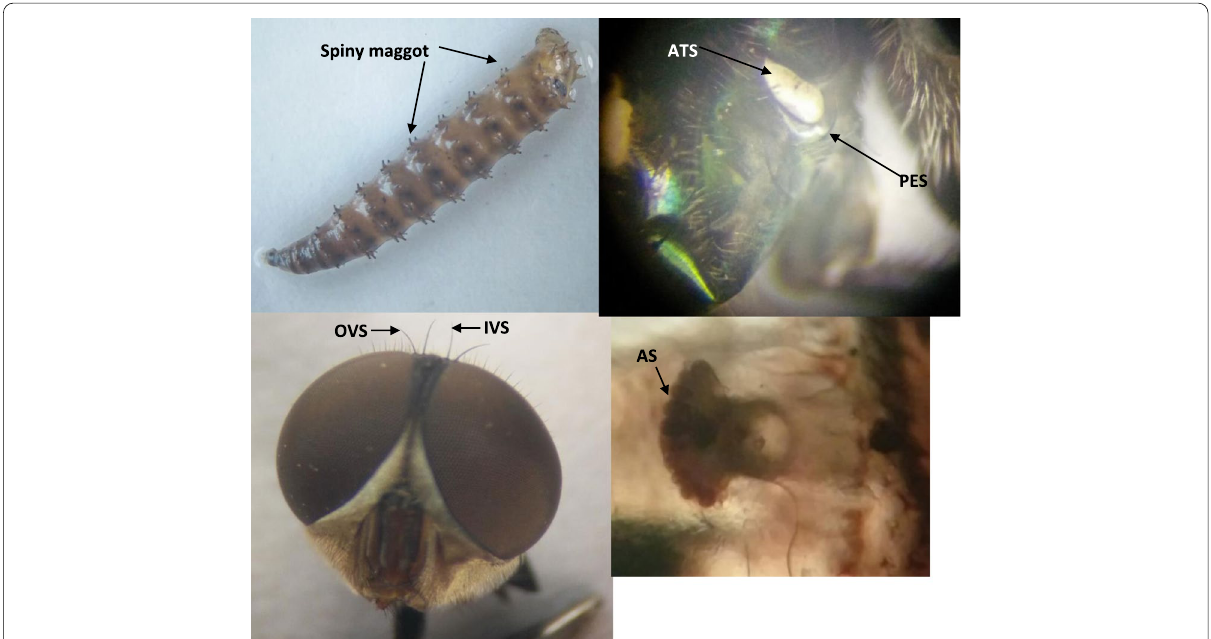
Fig. 2 Gross and microscopic morphological features of male Chrysomya rufifacies ( white); PES—proepisternal seta; OVS—outer vertical seta; IVS—inner vertical seta; AS—anterior spiracle (10 finger projections)